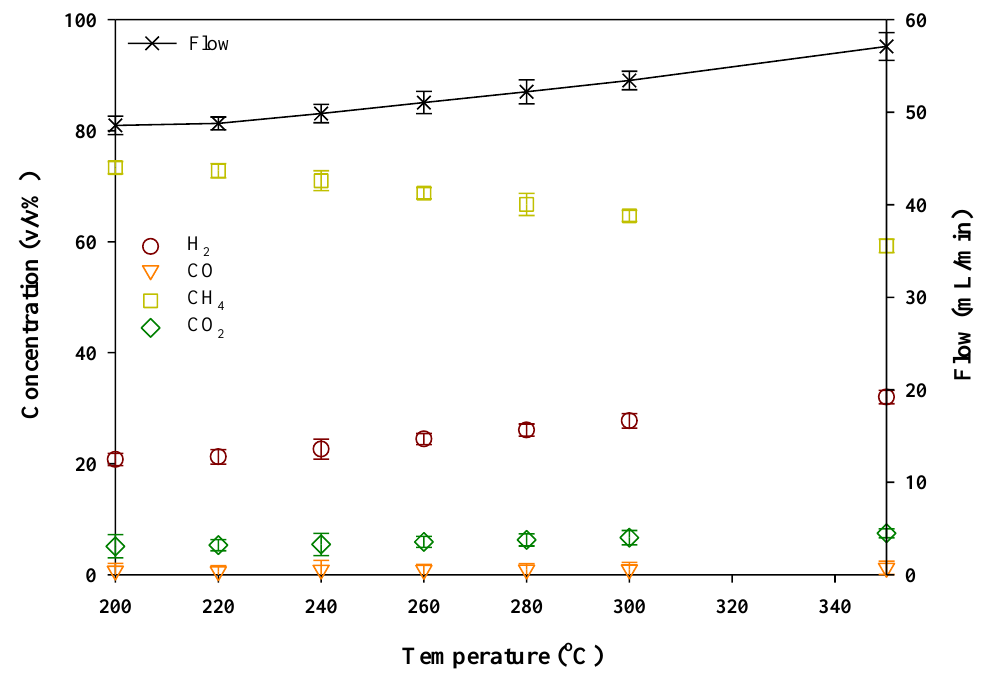
Figure 8. The concentration of the final out gases after the methanation reaction depending on reaction temperatures (Inlet gas ratio: H 2 :CO 2 = 4:1 to H 2 :CO = 3:1).